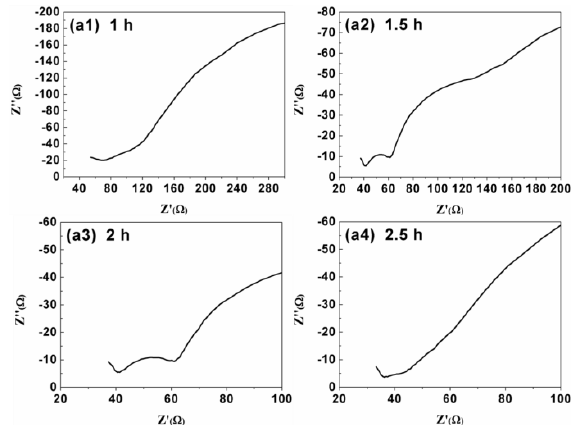
Figure 4. Impedance test images with deposition time of ( a1 ) 1 h, ( a2 ) 1.5 h, ( a3 ) 2 h, and ( a4 ) 2.5 h, respectively.